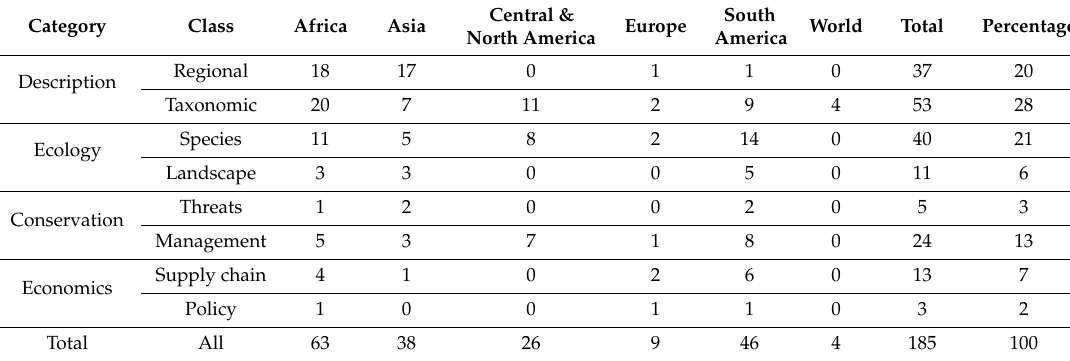
Figure 3. The distribution of study categories by region. Percentages are calculated from n = 185. Table 2. Numbers of different categories of articles.